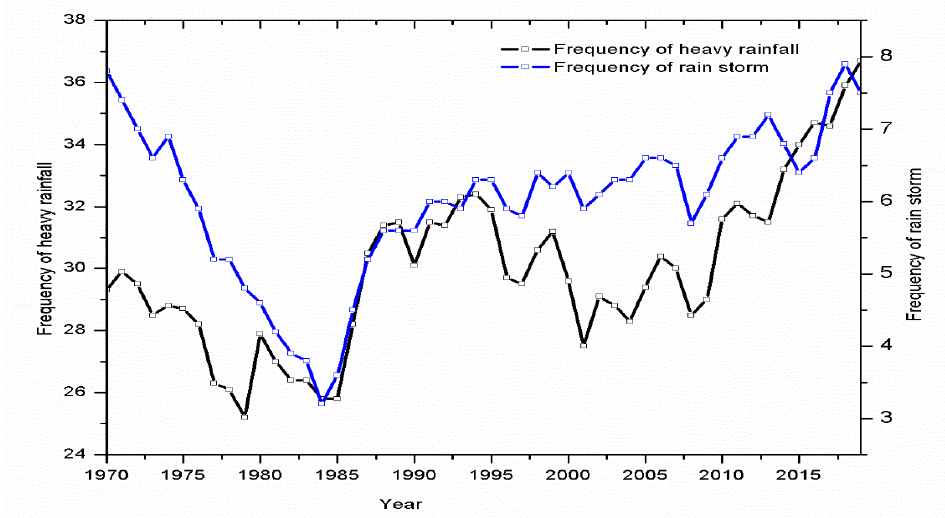
Figure 4. Interdecadal variability in frequency of heavy rainfall and rainstorms over northeast China during 1961–2019. during 1961–2019.